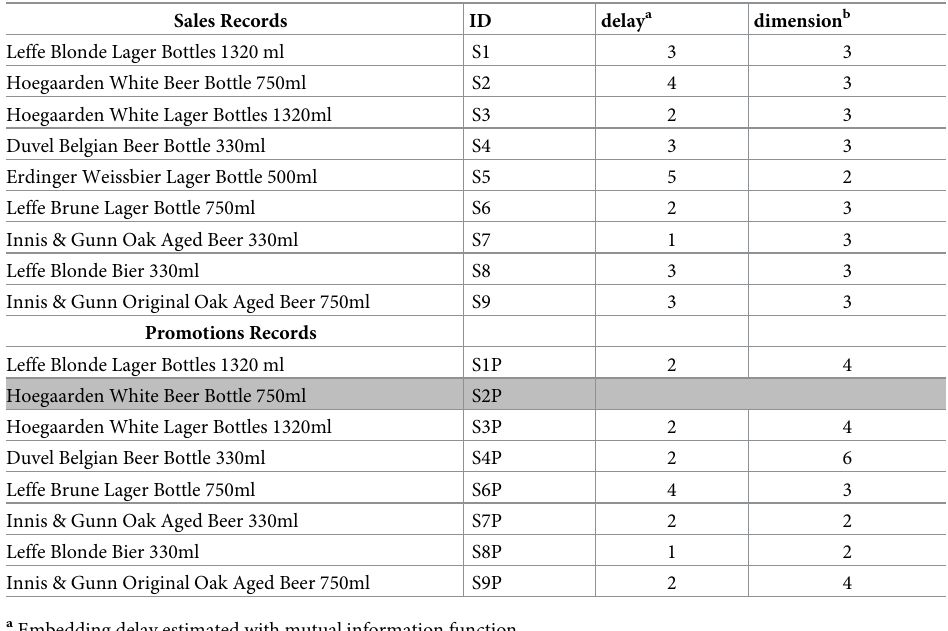
a Embedding delay estimated with mutual information function b Embedding dimension estimated with false-nearest-neighbors test. Shaded rows indicate records for which these statistics could not be calculated. These records were deleted from further